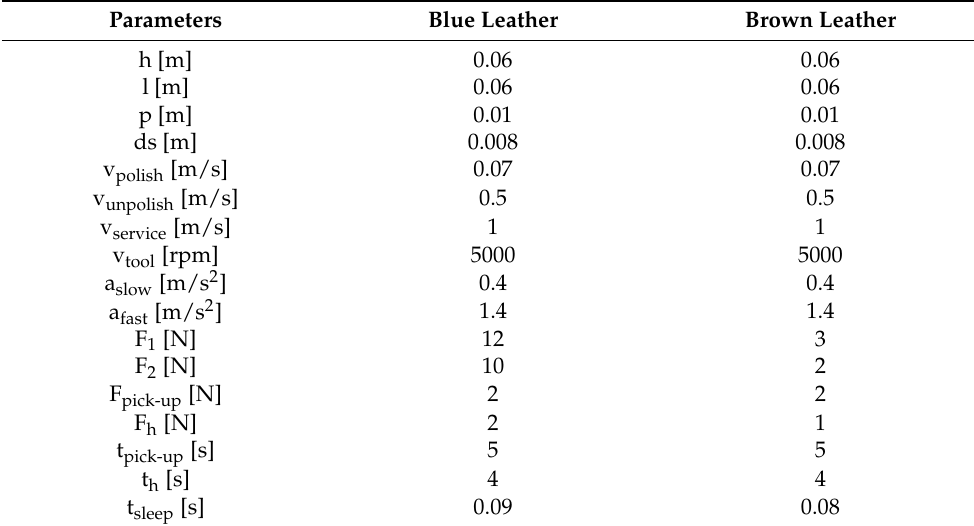
Table 1. Inputs of the process related to the results shown in Figure 19.